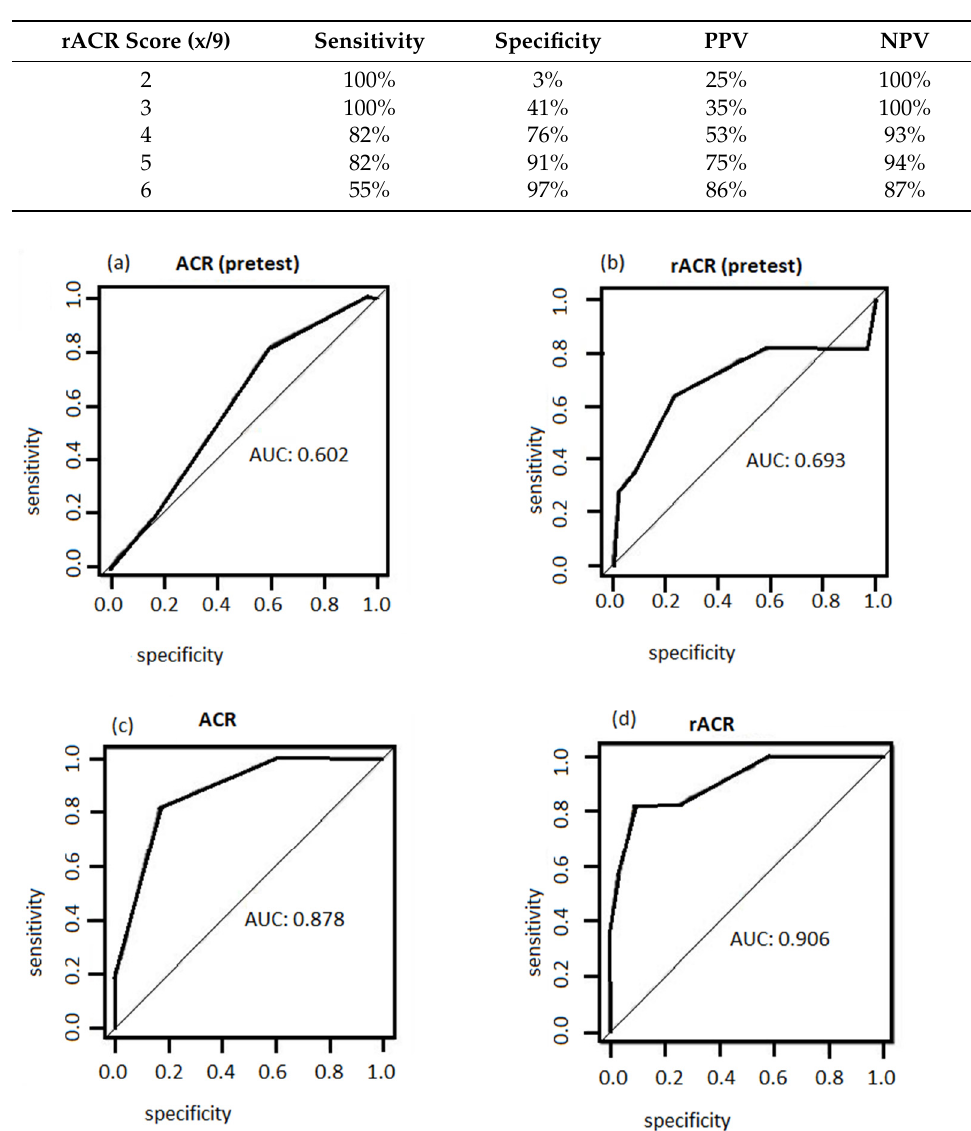
Figure 1. Receiver operating characteristics analysis curves for pre-test ACR ( a ), pre-test rACR ( b ), ACR ( c ), and rACR ( d ) scores and TAB results.